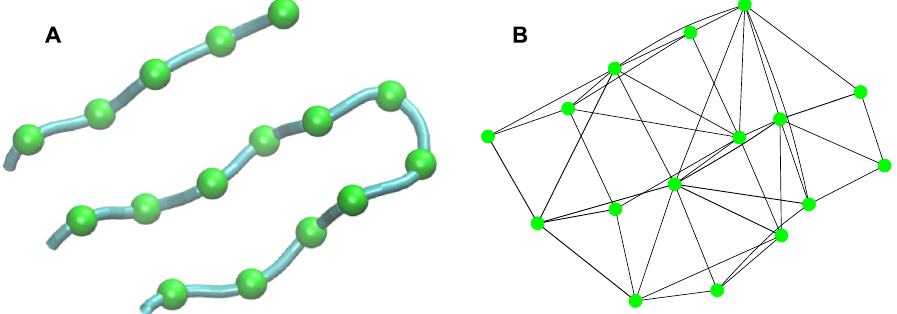
Fig 3. Fragment of protein G with associated interaction graph ( R cutoff = 7 Å ). A pair of residues is assigned a connection whenever their side chain beads are within R cutoff for any side chain states.